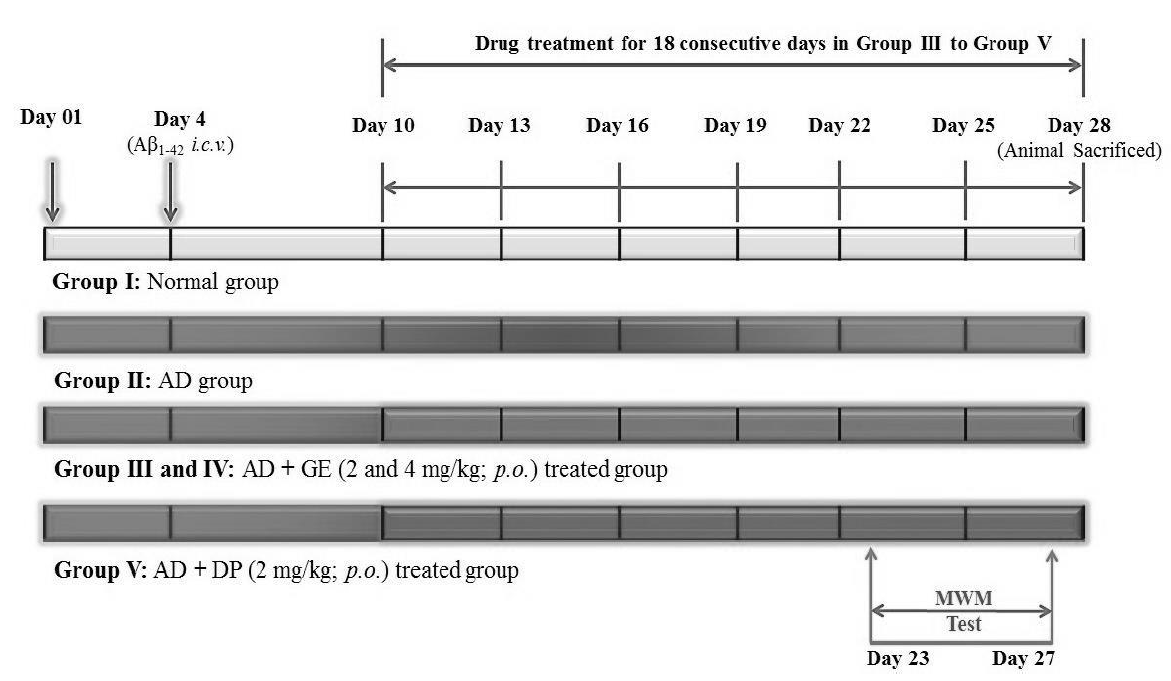
Figure 5. Experimental protocol for the screening of GE effect in the AD model. Abbreviations : Aβ 1– 42 , beta-amyloid peptide; AD, Alzheimer’s disease; DP, donepezil; GE, gefitinib; i.c.v. ; intracerebro- ventricular; MWM, Morris water maze test.